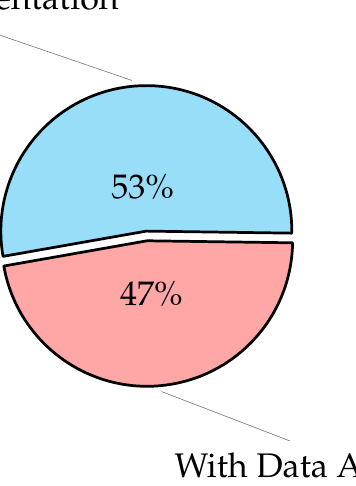
Figure 11. Data Augmentation distribution using deep learning aided thoracic diseases detection in the recent years.